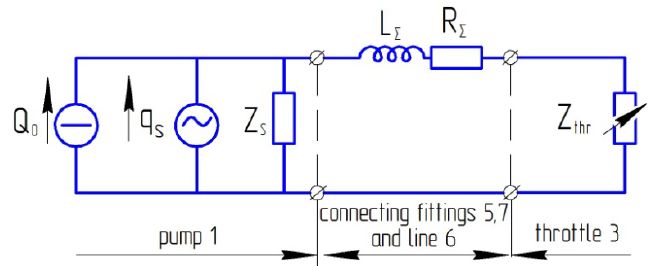
Figure 10. Calculated hydrodynamic model of the bench system implementing an active load. R Σ , L Σ —active resistance and “inertia” of aggregates’ internal channels, connecting fittings and connecting line; Z thr —throttle impedance.